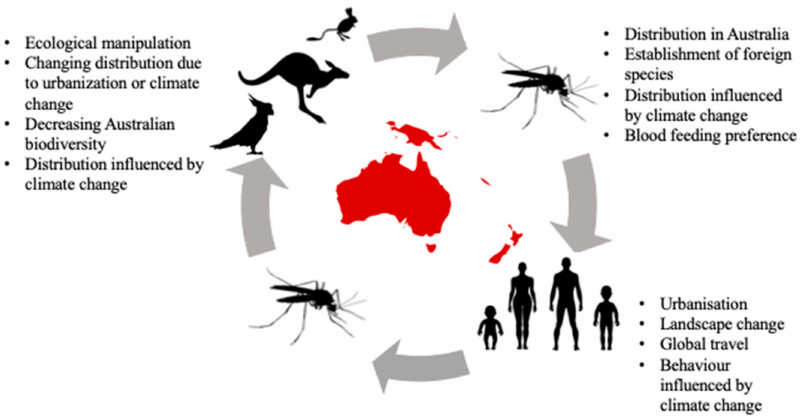
Figure 1. Relationship between Australian wildlife, mosquitoes, and humans. Often mosquito-borne diseases are often spread from human to human via the bite of a mosquito; however, consideration of Australian wildlife is important as they are often hosts for these pathogens. There are also many factors that can determine the spread of mosquito-borne disease, including the change in wildlife distribution, which should be considered when developing strategies to minimize the spread of